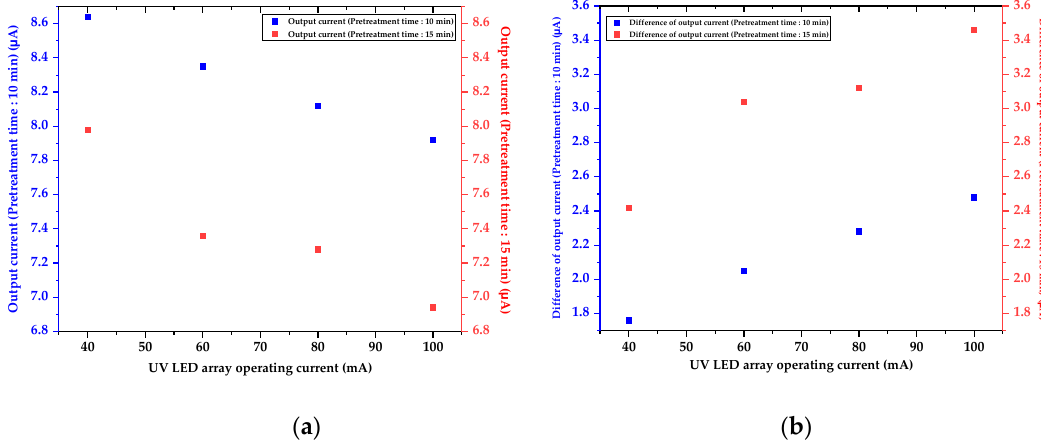
Figure 14. ( a ) Graph of the output current as functions of the pretreatment time and the UV LED array operating current and ( b ) graph of the difference of the output current as a function of the pretreatment time and the UV LED operating current.